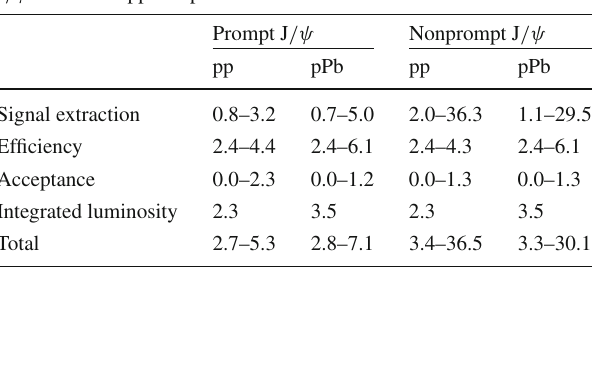
Table 3 Summary of the relative systematic uncertainties for the cross section measurements, given in percentages, for prompt and nonprompt J /ψ mesons in pp and pPb collisions